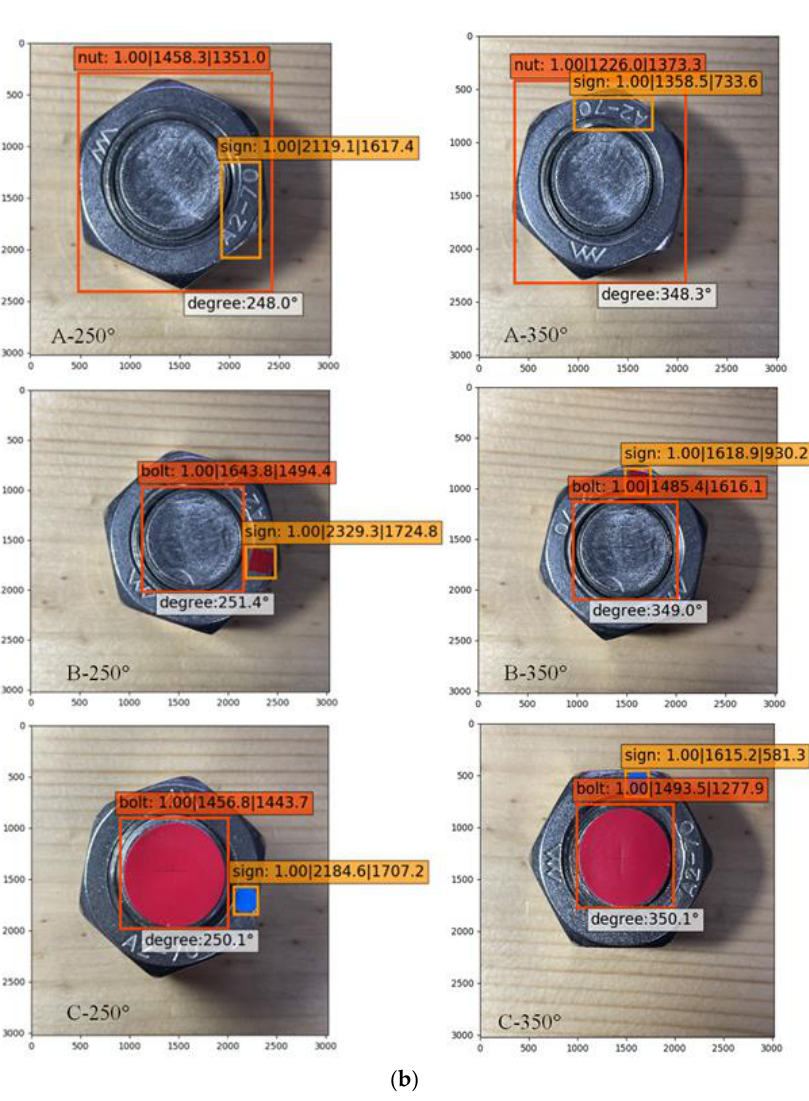
Figure 9. Best identification of rotation angles: ( a ) 50° and 150°; ( b ) 250° and 350°.